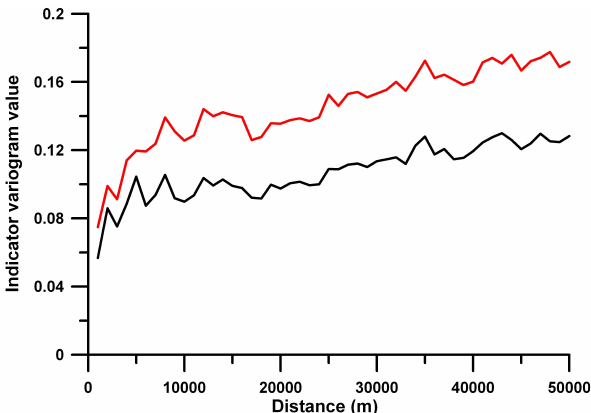
Fig. 7. Empirical indicator variograms calculated for deethylatra- sine for the 85 % and 90 % values of the